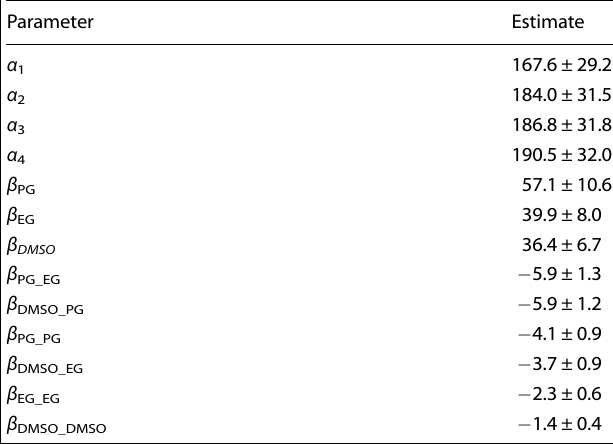
Table 5. Numerical thresholds ( α ) and coef fi cients ( β ) for the ordinal model of vitri fi ability 25 .